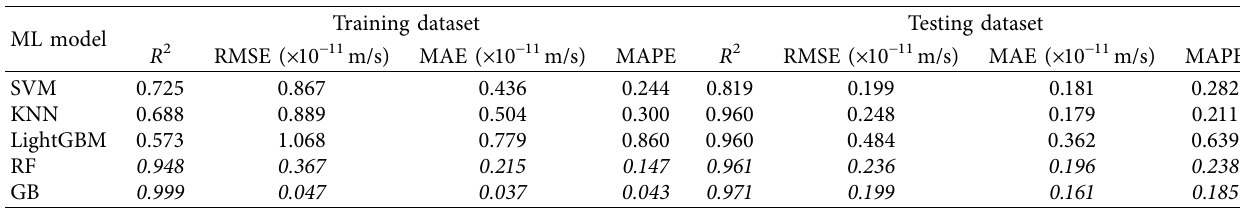
Table 4: Best performance of the ML model according to highest R 2 for the testing